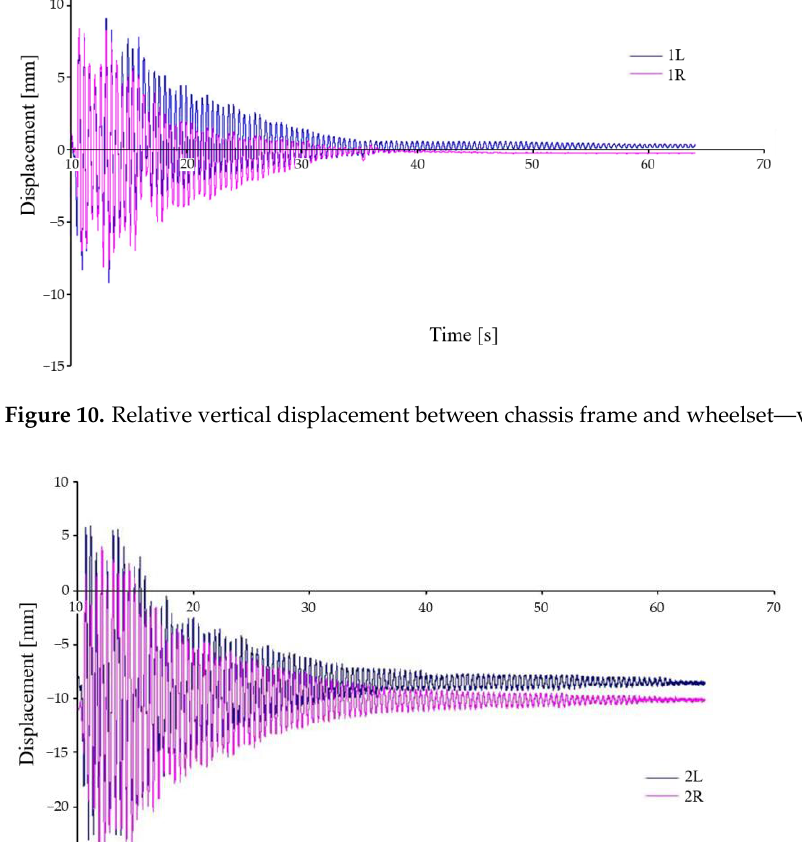
chassis frame and body vertical deflection sensor, left/right side, 3L/R—car body vertical accelera- tion sensor, left/right side.